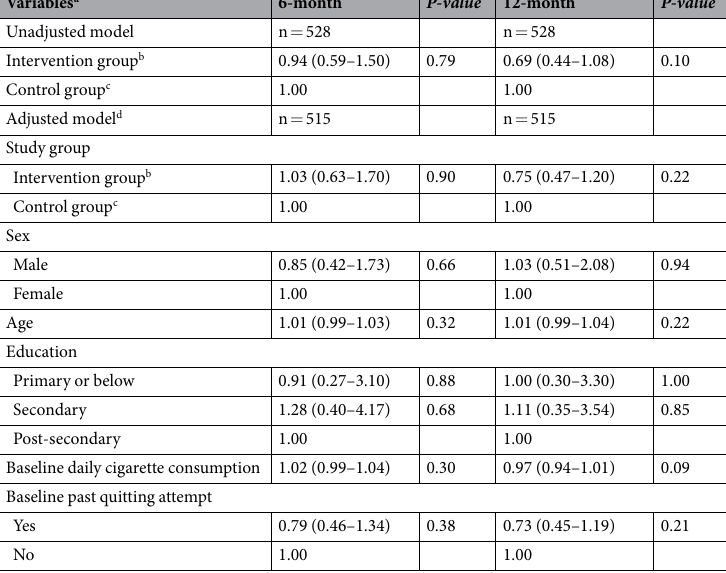
Table 3. Factors predicting smoking cessation at 6 and 12 months follow-up. a By intention-to-treat analysis: assume all non-responded follow-up patients as current smokers and they did not made a quit attempt over the period and did not change their behaviour compared to baseline. b Brief advice based on risk communication. c Usual care. d Model adjusted for all the variables